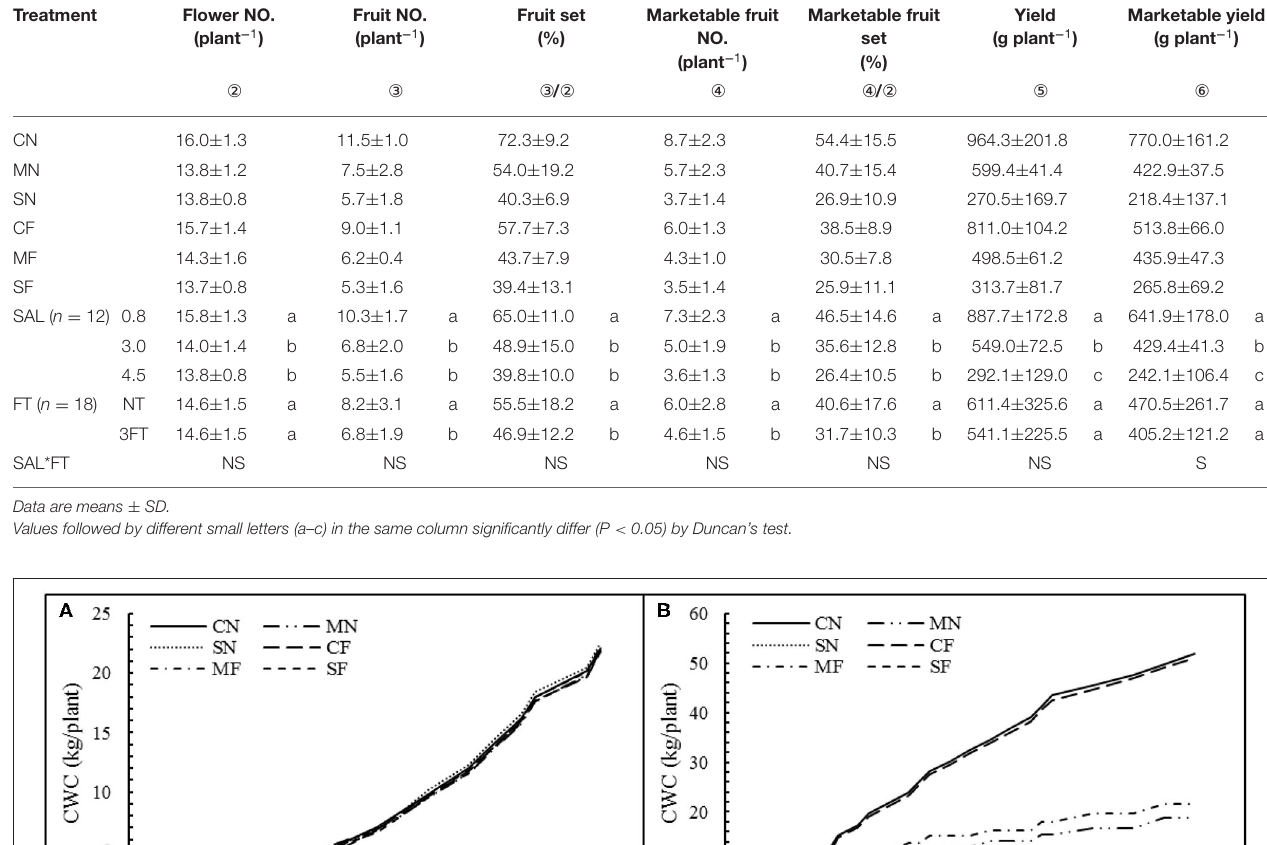
TABLE 3 | Combined treatment on flower number, fruit number, fruit set, marketable fruit number, marketable fruit set, yield, and marketable yield. Treatment